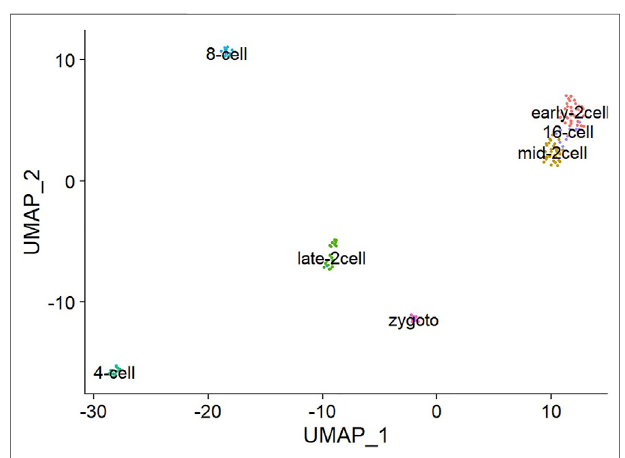
FIGURE 9 | Deng data set gene marker